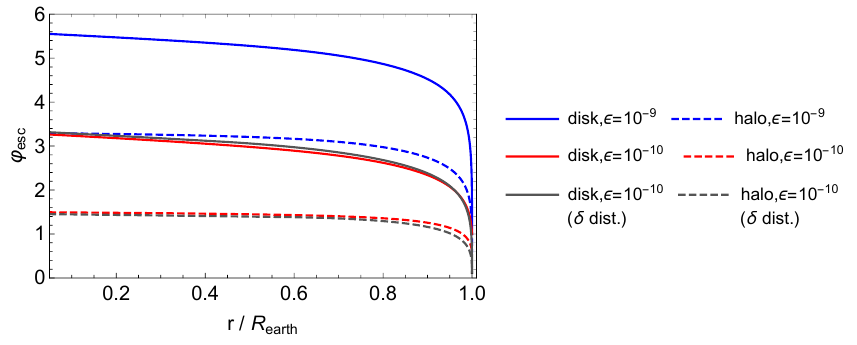
Figure 10 . Maximum possible mirror electric potential inside the Earth, parametrized in terms of ϕ ( r ) , shown for mirror particles in a halo (solid) and disk (dashed) distribution. Results esc are shown for a delta function distribution of speeds at infinity with (cid:15) = 10 − 10 (grey) and for a Maxwell-Boltzmann distribution of speeds at infinity with (cid:15) = 10 − 10 (red) and (cid:15) = 10 − 9